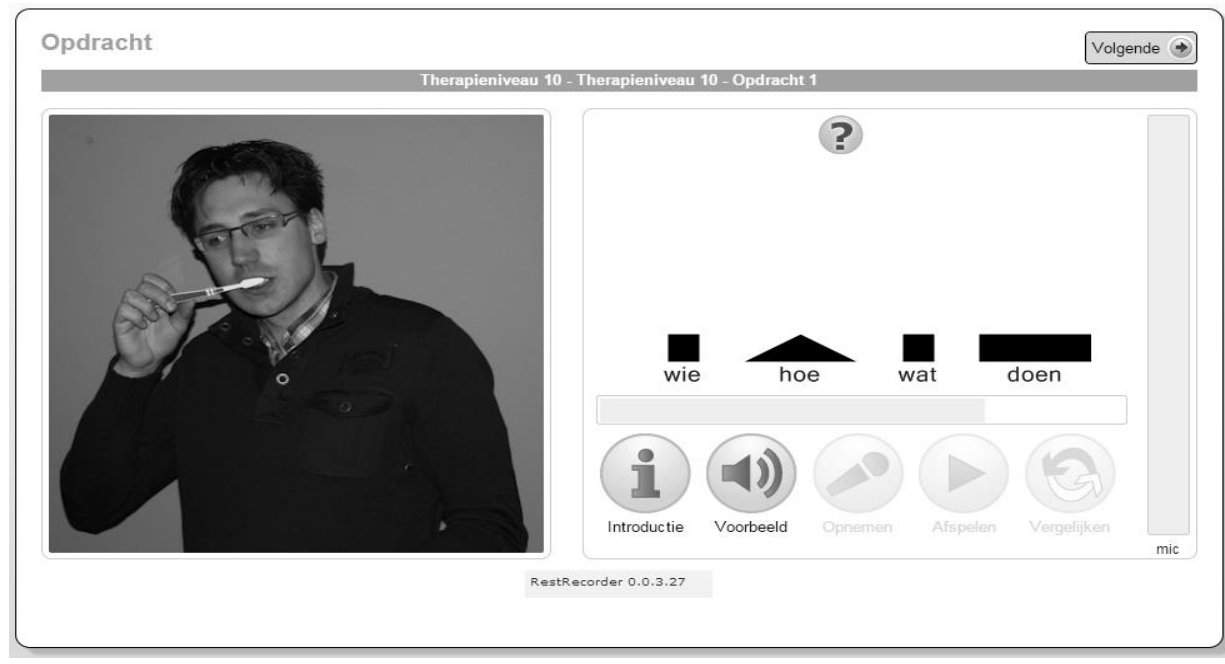
Figure 1. User interface of the first item of the tenth therapy level of e-REST when enrolled in the first therapy cycle. Target elliptical utterance: Paul zonder tandpasta tanden poetsen , ‘Paul brushing teeth without toothpaste’. For an explanation of the buttons depicted in the interface see the